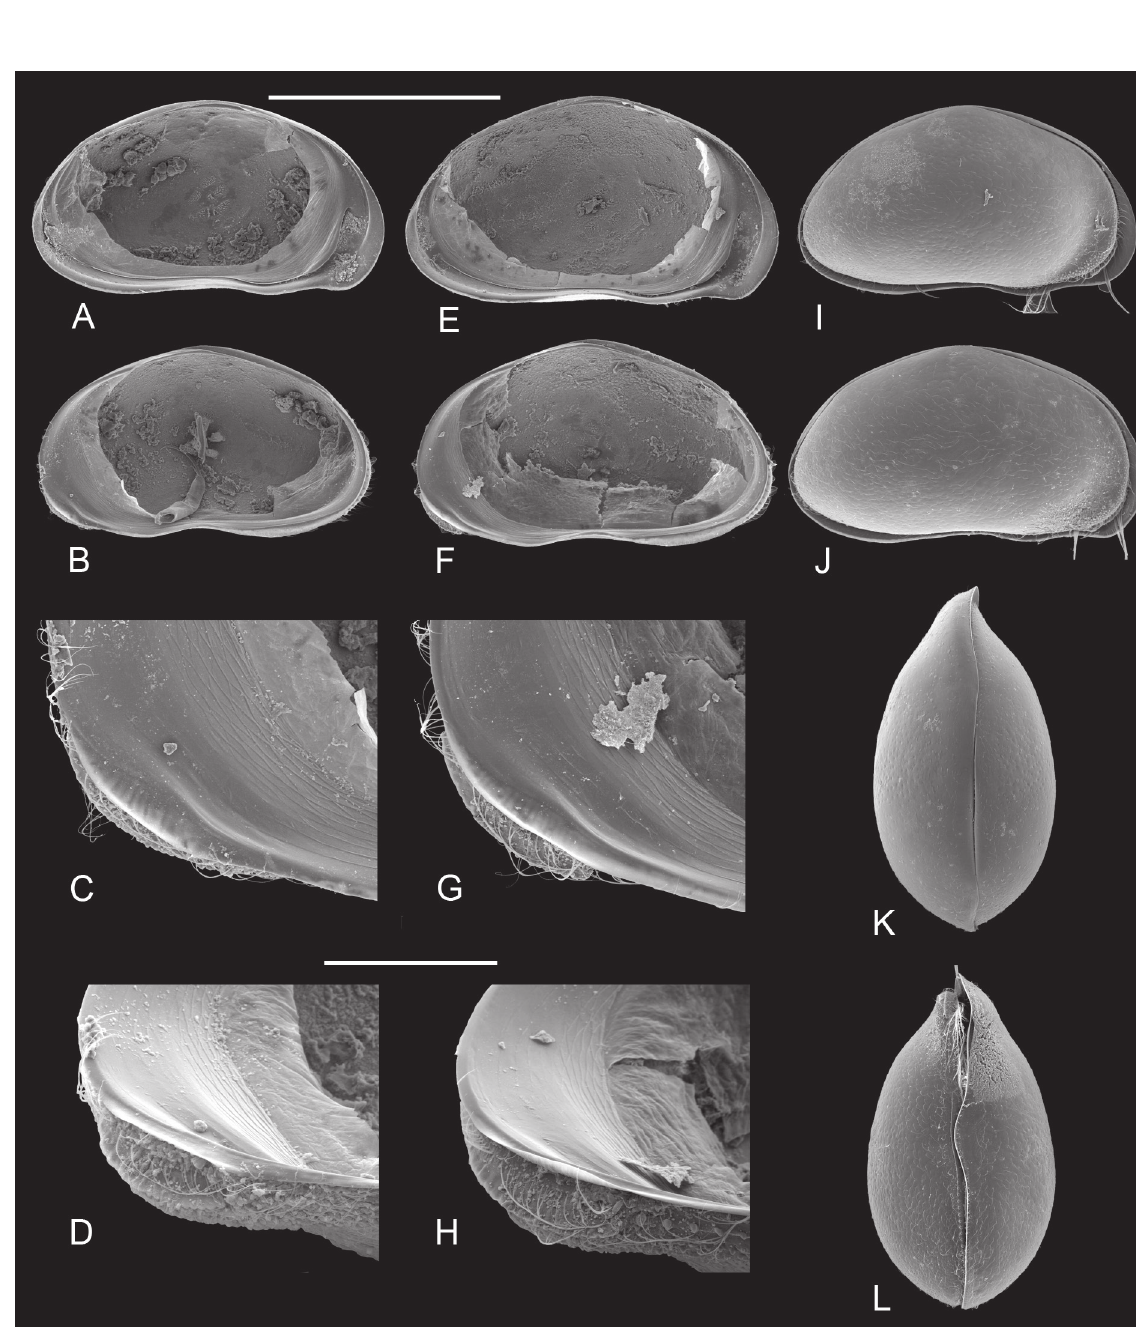
Fig. 21. Bennelongia calei sp. nov. — A-H , J-L . Fraser lake (type locality, females, DJc/18): A . Paratype, lVi (Oc.3344). B . Paratype, rVi (idem). C . Paratype, rVI, detail anterior (idem). D . Paratype, rVI, detail anterior, tilted (idem). E . Holotype, lVi (WaMc52335). F . Holotype, rVI (idem). G . Holotype, rVi, detail anterior (idem). H . Holotype, rVi, detail anterior, tilted (idem). J . Paratype, cprl (Oc.3345). K . Paratype, cpD (WaMc52338). L . Paratype, cpV (WaMc52337). — I . Oak Flat W pit gnamma, via Goomalling (BVt/11/04, non-type female, WaMc52343). cprl. scales: a-B, e-F, I-l = 1 mm; c-D, G-H = 200